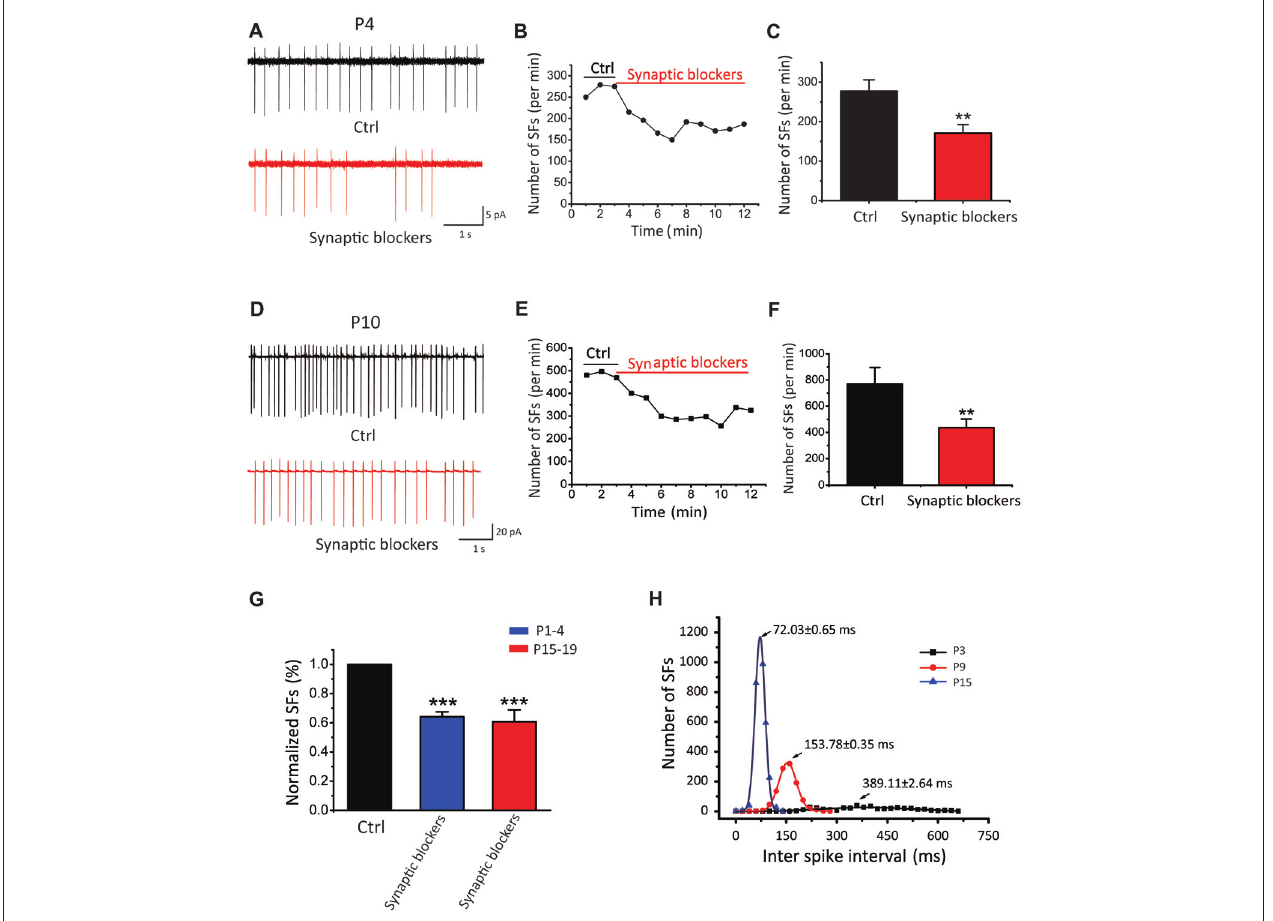
FIGURE 2 | SFs are intrinsically driven and augmented by synaptic inputs in auditory central neurons. (A–F) Examples showing SFs before and after blocking synaptic inputs with a cocktail of NBQX, APV, bicu and stry in P4 (A–C) and P10 (D–F) auditory central neurons; Time courses of representative recordings from neurons shown in (A,B) are plotted in ( B,E) . Comparisons of the average frequency of SFs in normal ACSF and synaptic blocker are shown in (C,F) for two age groups (P1–4 in control: 277.21 ± 28.69 spikes/min, synaptic blockers: 170.80 ± 28.69 spikes/min, P15–19 in control: 769.18 ± 126.48 spikes/min, synaptic blockers: 436.38 ± 65.46 spikes/min) recorded from 30 neurons in P15–19 mice. (G) Normalized firing rates in control and after application of synaptic blockers. (H) Distribution histograms of inter spike intervals for three typical IF(+) neurons at P3, P9 and P15, respectively. Smooth curves represent the best fits to the data − ( x − µ) 2 √ with the Gaussian function in the form of: f ( x ) = 1 e 2 σ 2 , where µ denotes the x value at the center of the normal distribution, σ is the standard deviation σ 2 π from the x (P3: µ = 389.11 ± 2.64 ms, σ = 280 ± 50.96 ms; P9: µ = 153.78 ± 0.35 ms, σ = 51.82 ± 0.79 ms; P15: µ = 72.03 ± 0.65 ms, σ = 29.23 ± 1.92